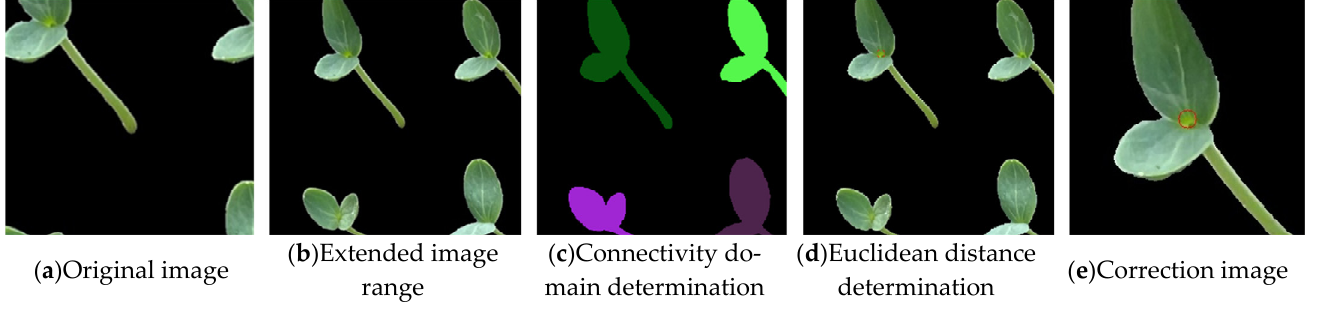
Figure 5. The skewed seedling correction process.